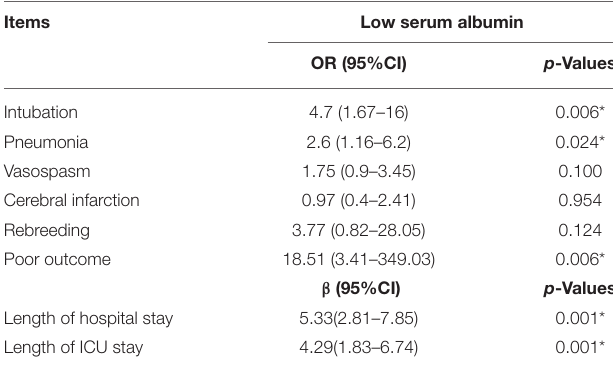
TABLE 3 | Multivariable analysis of serum albumin levels in patients with spontaneous subarachnoid